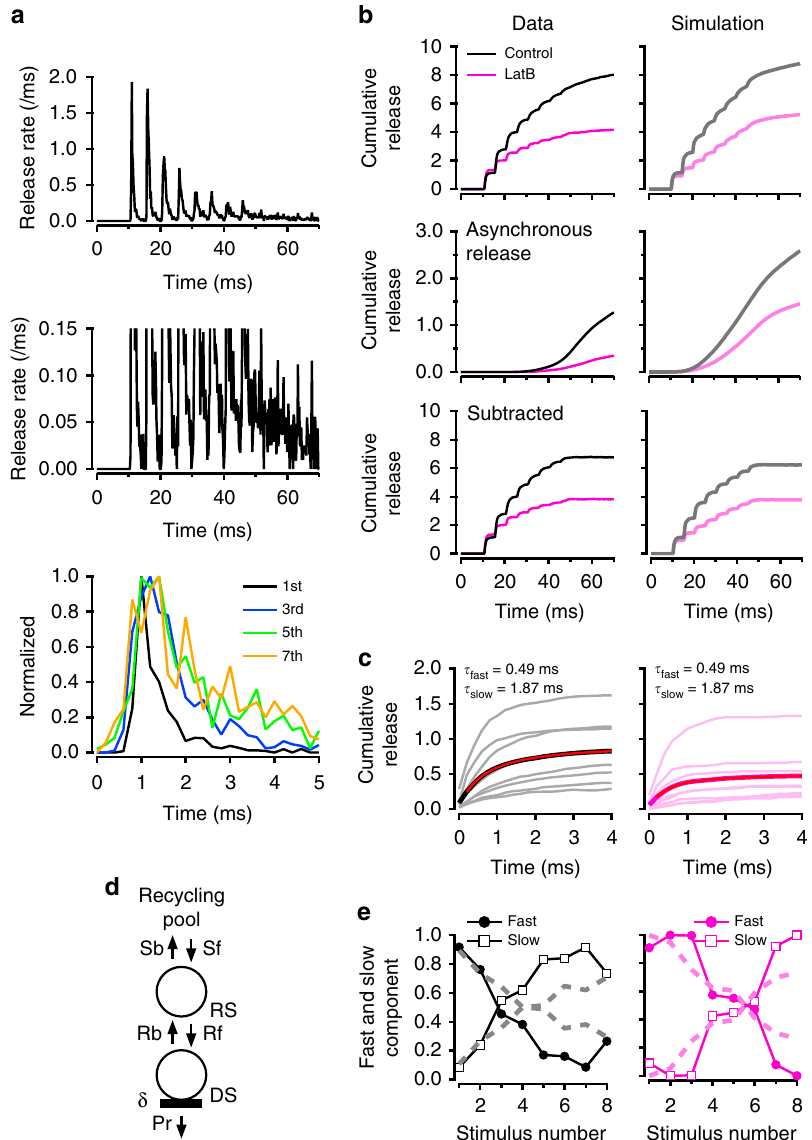
Fig. 3 Fast, slow and asynchronous release during trains, in control and in LatB. a Average release rate (per ms and per simple synapse; 3 mM external [Ca 2 + ] and 200 Hz stimulation; n = 11 experiments). Middle panel: Expanded vertical scale highlighting asynchronous release. Lower panel: Scaled latency distributions for stimuli 1, 3, 5 and 7 are superimposed to show a marked latency broadening during trains. b Effect of LatB on cumulative latency counts during trains. Overall latency counts (upper row) have been decomposed into a superslow component representing asynchronous release (middle row) and a phasic component (lower row). Black: Control synapses (3 mM external [Ca 2 + ] and 200 Hz stimulation). Red: Synapses pretreated with LatB to inhibit actin-dependent SV movement. c Superimposed cumulative latency distributions for each AP stimulation during an 8-AP train, both for control data (left) and in LatB (right). Average traces of 8-AP responses (thick black curve) is fi tted with a double exponential (red) with indicated τ fast and τ slow values. d Full model with reversible transition between recycling pool and replacement site (forward: S f , backward: S b ). e Relative contributions of τ fast and τ slow component as a function of stimulus number (symbols and continuous lines: experimental; dashed lines: